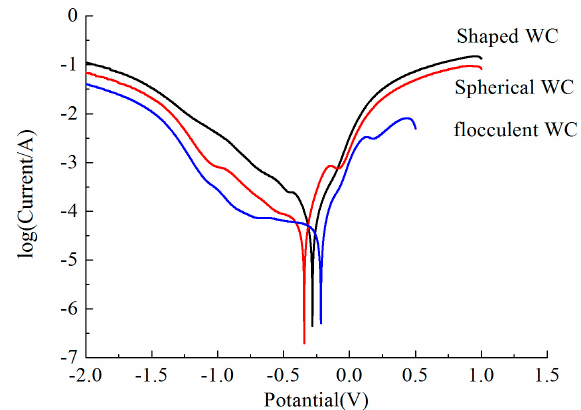
Figure 7. Electrochemical polarization curves of three types of WC cladding coatings.